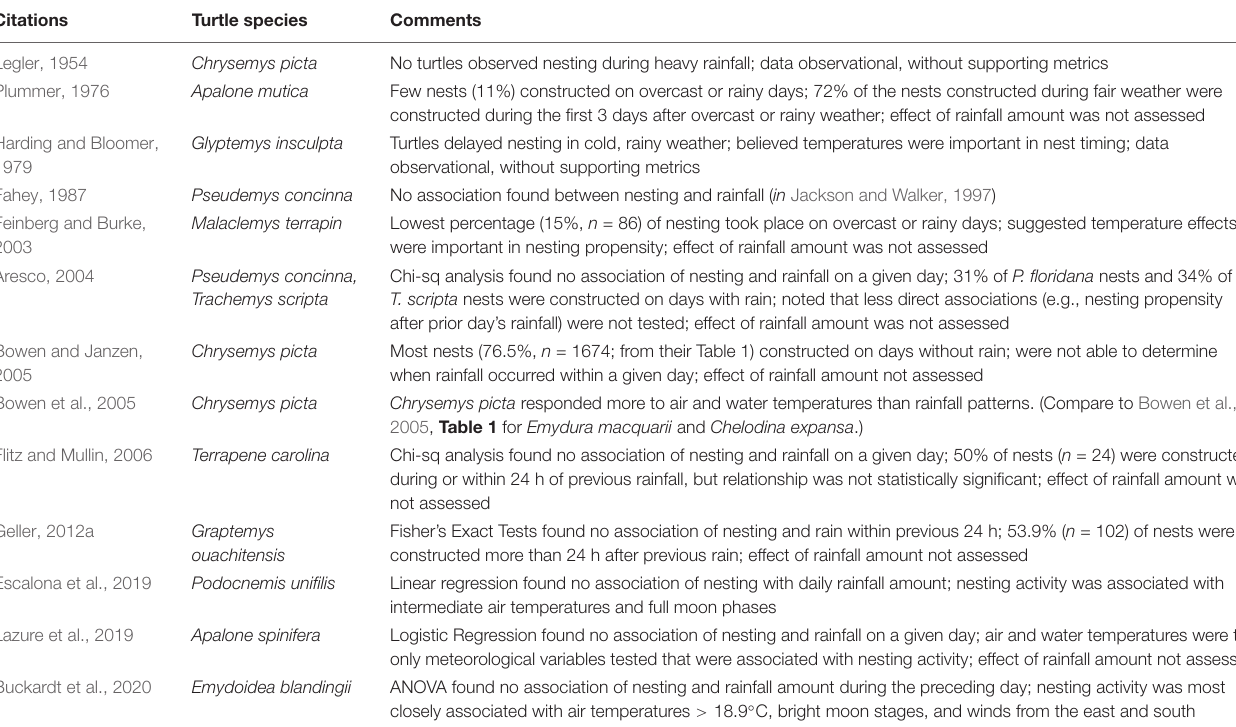
TABLE 2 | Papers suggesting freshwater turtles do not nest in association with